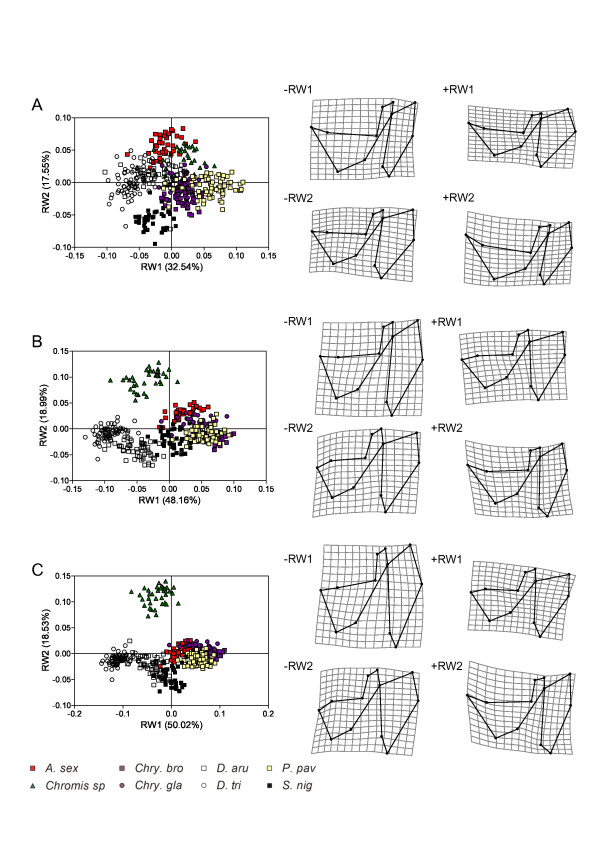
Ontogenetic dynamics of the patterns of suspensorium and opercle shape disparity. Relative warps analyses of the suspensorium and opercle shapes at the three ontogenetic stages. A, shapes at the settlement stage. B, shapes at an intermediate size of 60 mm SL. C, shapes at the maximum adult body size. TPS deformation grids indicate shape variation represented by RW1 and RW2 (minimal (-RW) and maximal (+RW) values).